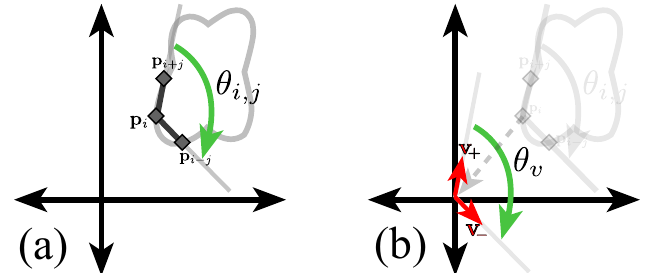
Figure 5. Graphical representation of the calculation of the inner point angle of point p i at separation j . ( a ) Representation of the inner angle of point p i at separation j . Notice that the points in the boundary are taken in clockwise order; ( b ) Representation of the translation vectors v + , v in